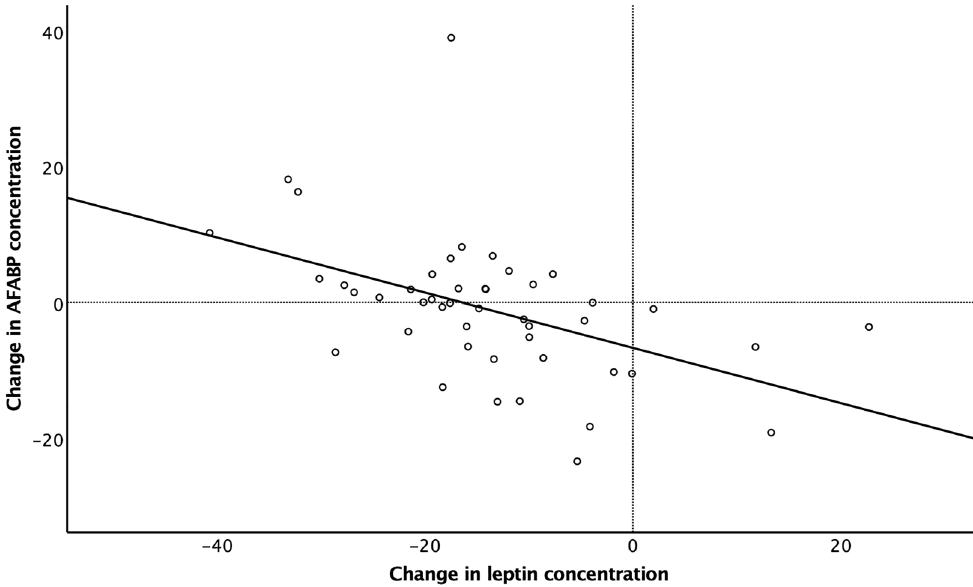
Figure 2. Correlation between change in serum leptin concentration (ng/mL) and change in serum AFABP concentration (ng/mL) during intervention (rho = − 0.530, p < 0.001, n =